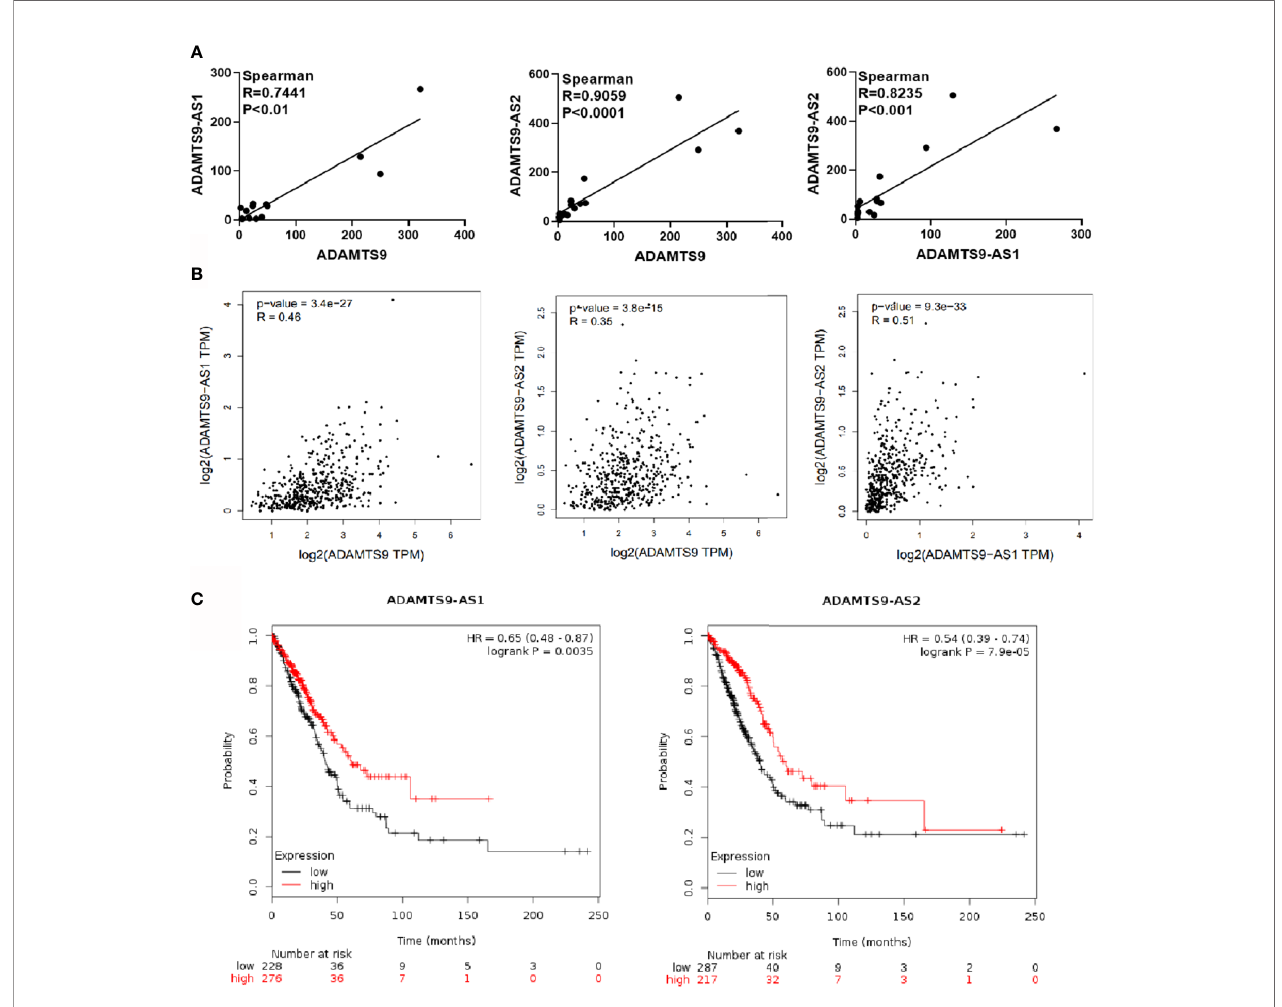
FIGURE 3 | The analysis of the correlation between ADAMTS9-AS1/ADAMTS9-AS2/ADAMTS9 respectively. (A) The gene expression pro fi le in the GEO database analyzes correlation analysis between ADAMTS9-AS1/ADAMTS9-AS2/ADAMTS9. (B) GEPIA veri fi es the correlation between ADAMTS9-AS1/ADAMTS9-AS2/ ADAMTS9. (C) The prognosis of ADAMTS9-AS1 and ADAMTS9-AS2 was analyzed by a Kaplan – Meier Plotter (P < 0.01, P <